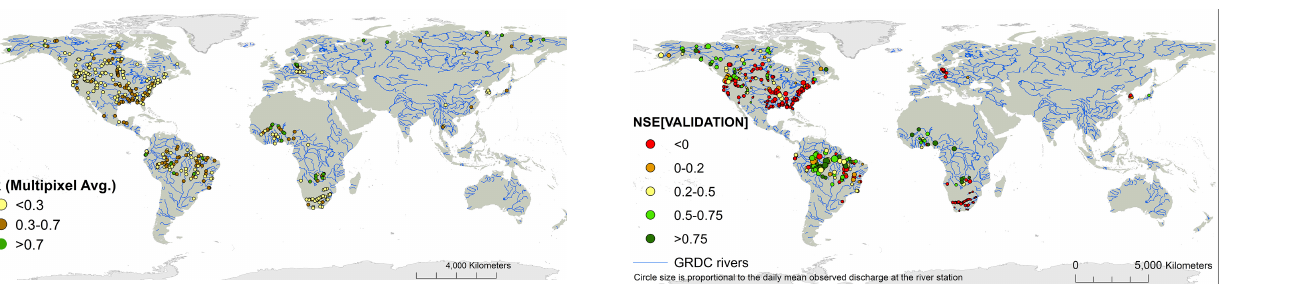
Figure 5. Nash–Sutcliffe efficiency of the validation ( n = 332 sta- tions). Globally, 154 stations have NSE > 0, of which 80 stations have NSE >